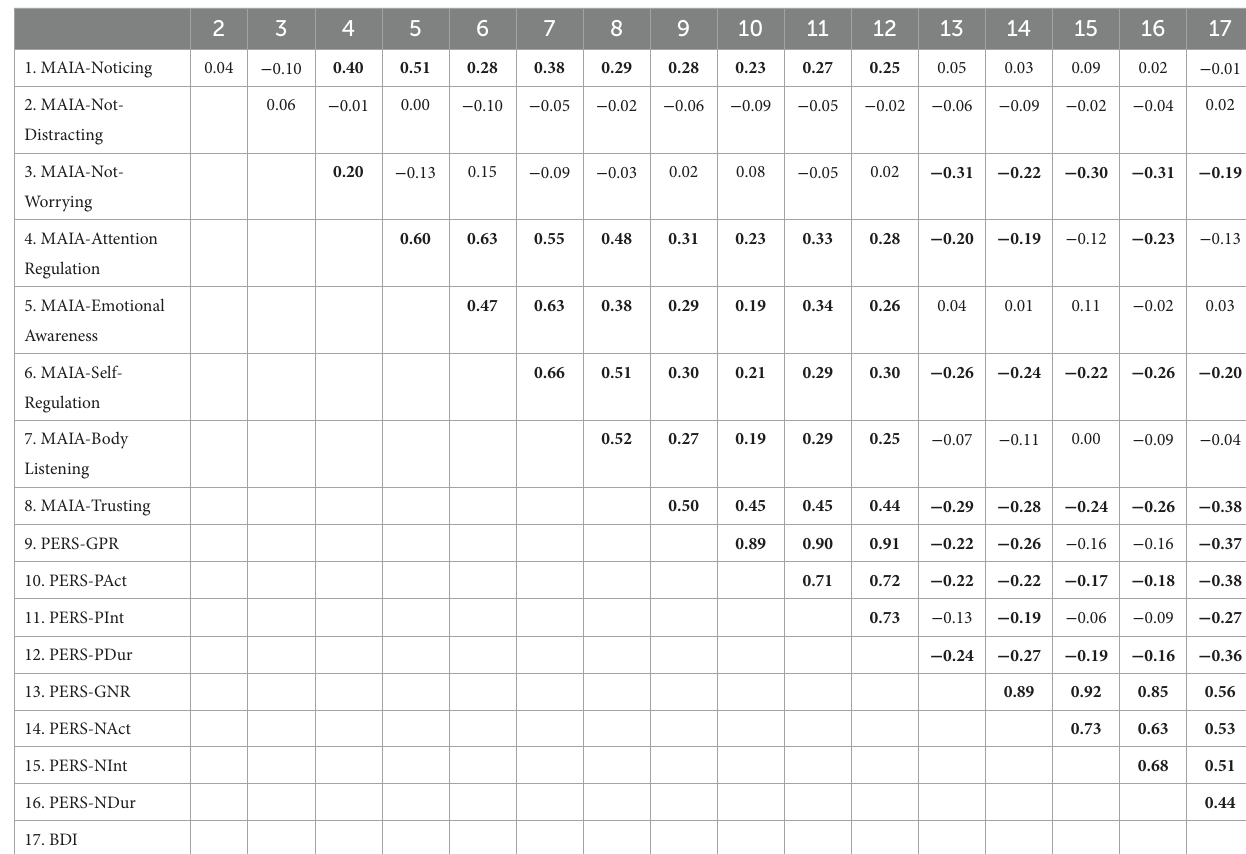
TABLE 1 Partial correlation between all